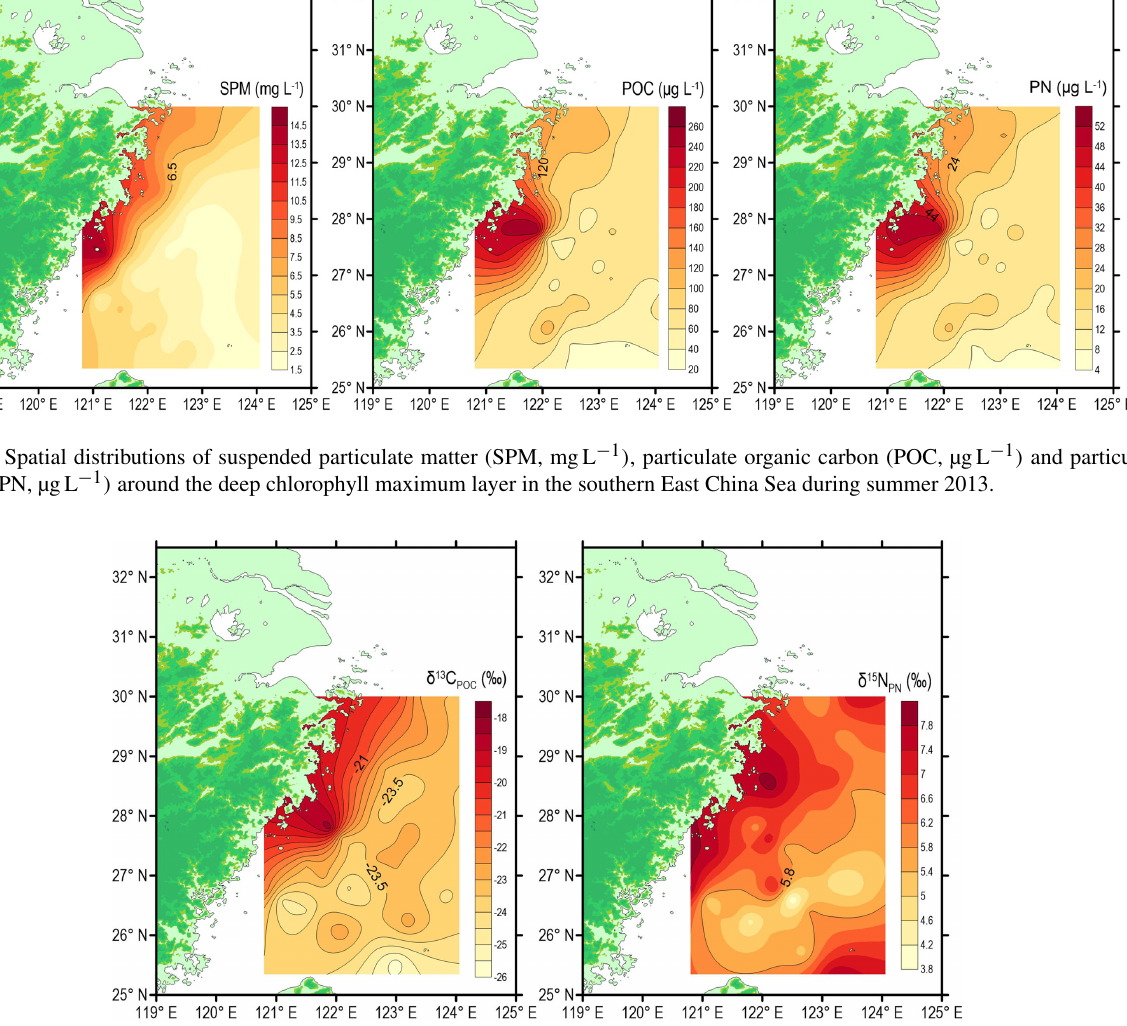
value of 17.7 µg L − 1 ( n = 36). The spatial distributions